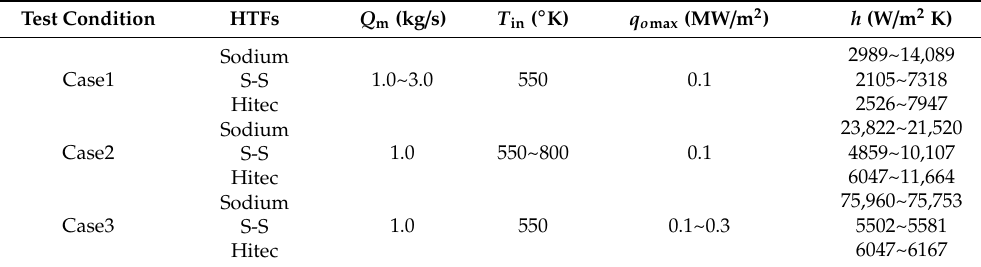
Table 2. The calculation parameters.